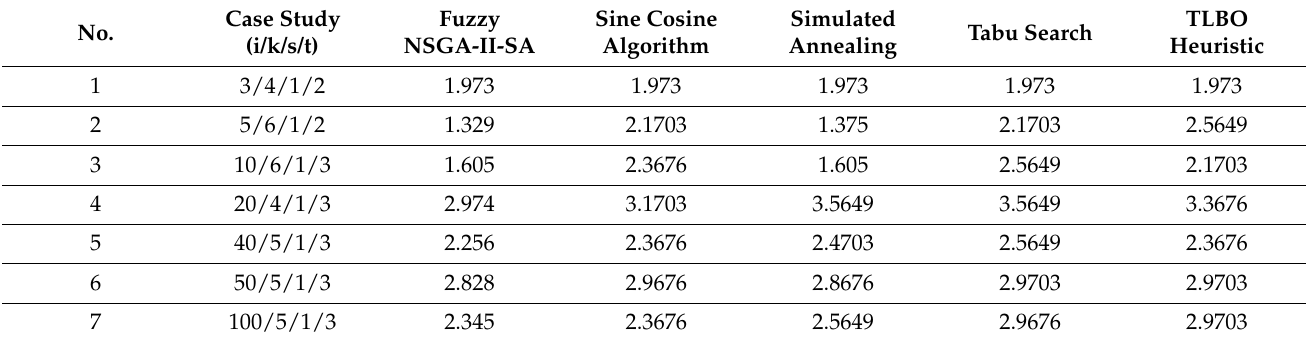
Table 11. Results of comparing the proposed method with other